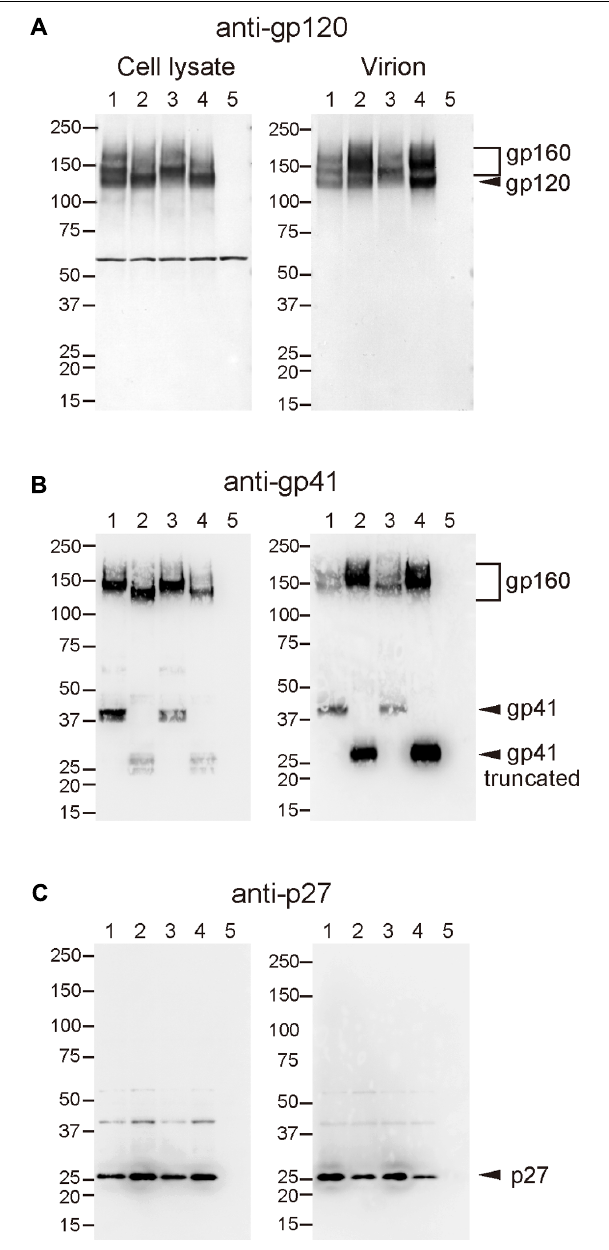
FIGURE 5 | Effect of B404-resistant mutations on the incorporation of Env into virions. Cell lysates (left panels) and virions (right panels) of SIVmac316 (lane 1), SS (lane 2), SN (lane 3), NS (lane 4), and mock-infected control (lane 5), which were prepared from transfected 293T cells, were analyzed byWestern blotting.Viral proteins gp120 (A) , gp41 (B) , and p27 (C) were detected using MAbs M318T (anti-gp120V2), B408 (anti-gp41 cluster I), and B450 (anti-p27),